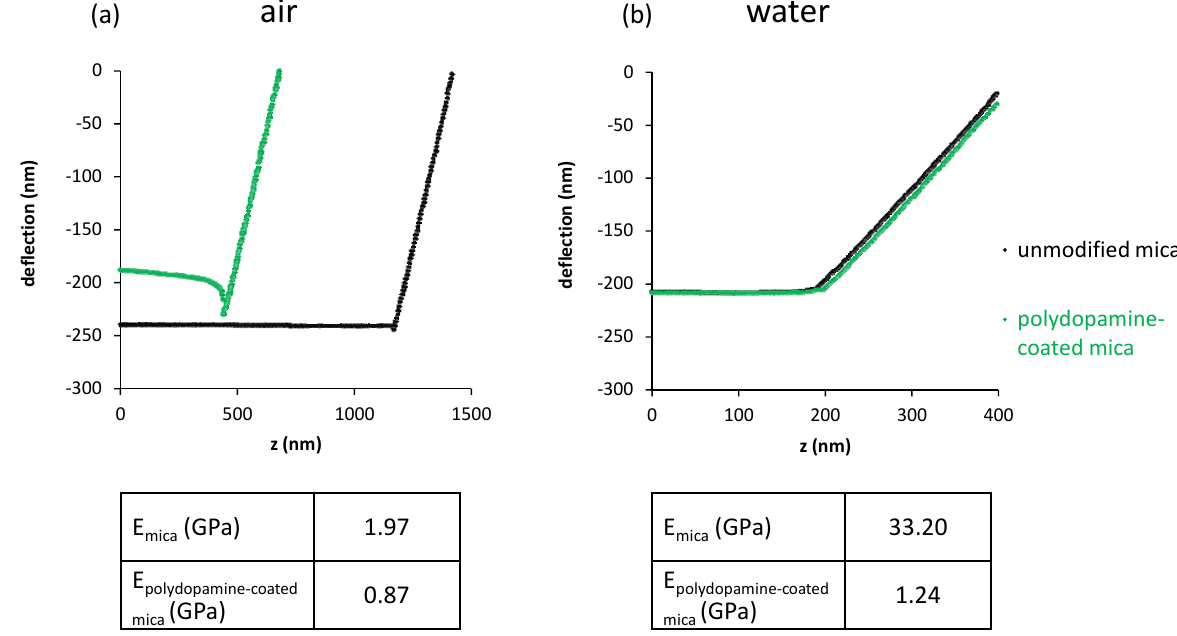
Figure 5. Force curves obtained ( a ) in air ( b ) in water for unmodified and polydopamine-coated mica, with corresponding calculated elastic